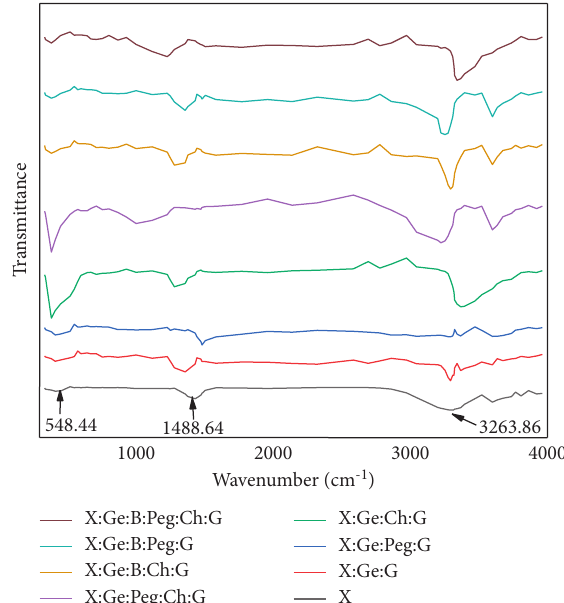
Figure 6: Hydrogel composites’ FTIR spectra. The stretching vibration of -COO ester bonds, C-N stretching, and OH bending cause peaks in the spectra between 1404 and 1500cm − 1 . Because of the (N-H) group and hydrogen-bonded hydroxyl group (O-H), a wide band formed at 3220–3334cm − 1 . Abbreviations. Xanthan gum (X), boric acid (B), gelatin (Ge), polyethylene glycol (Peg), chitosan (Ch), and glutar- aldehyde